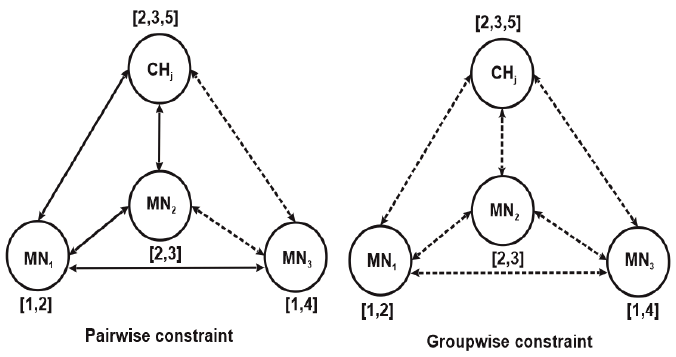
Figure 3. Illusration of pairwise and groupwise